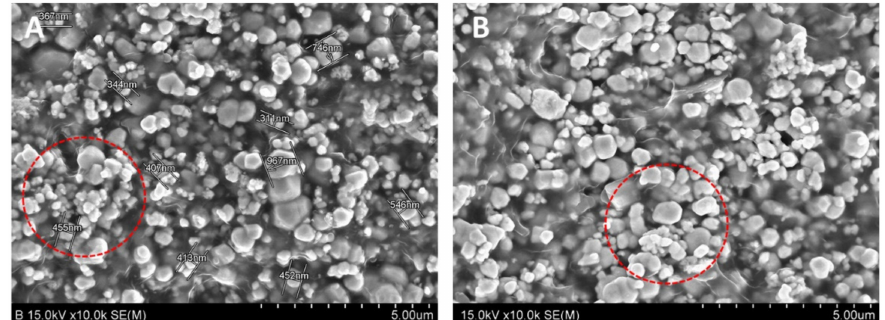
Figure 5. Comparison of nanoparticles and microparticles in cross-section of shielding sheet. ( A ) Nanoparticle shielding sheet; ( B ) microparticle shielding sheet (red circle is where clustering effect was observed).